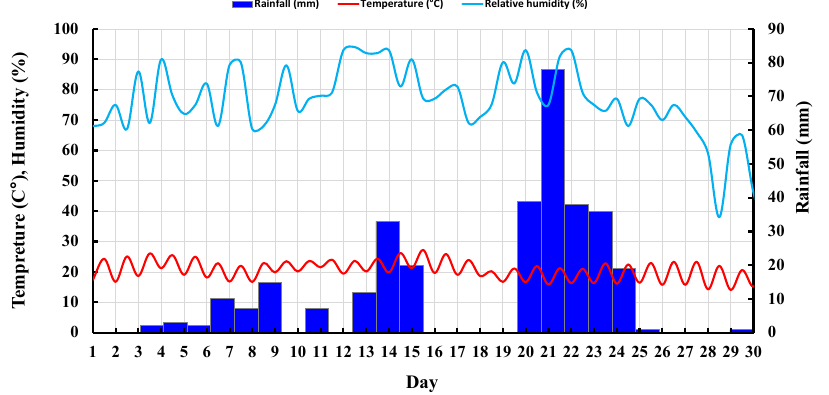
Figure 8. Recorded daily temperature, relative humidity, and rainfall in the field.